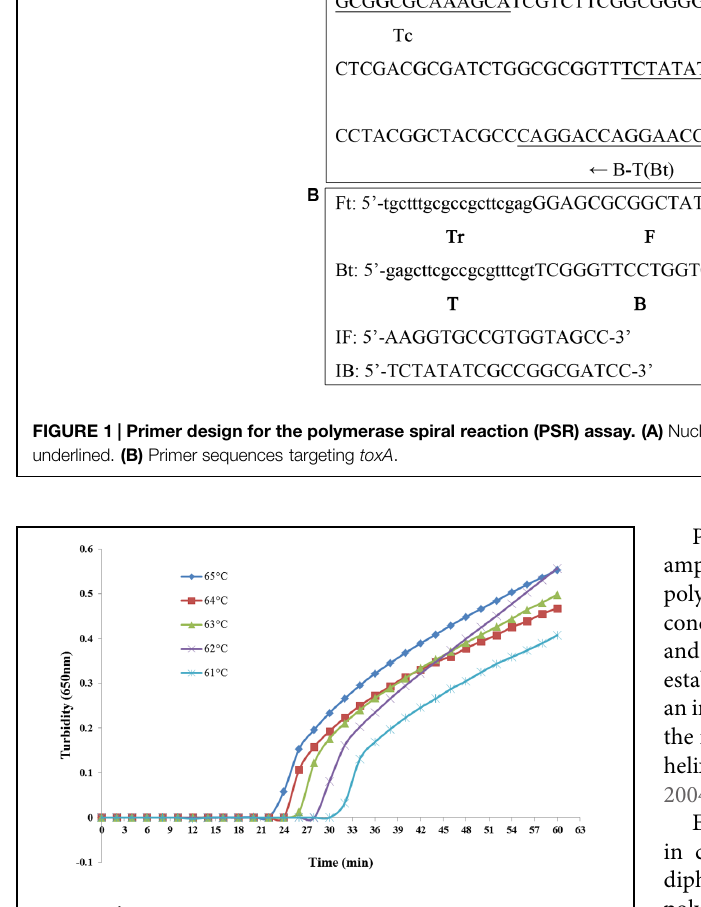
FIGURE 2 | PSR assay temperature optimization. Different temperatures (61–65 ◦ C at 1 ◦ C intervals) were tested and 65 ◦ C was chosen as the optimal temperature for PSR